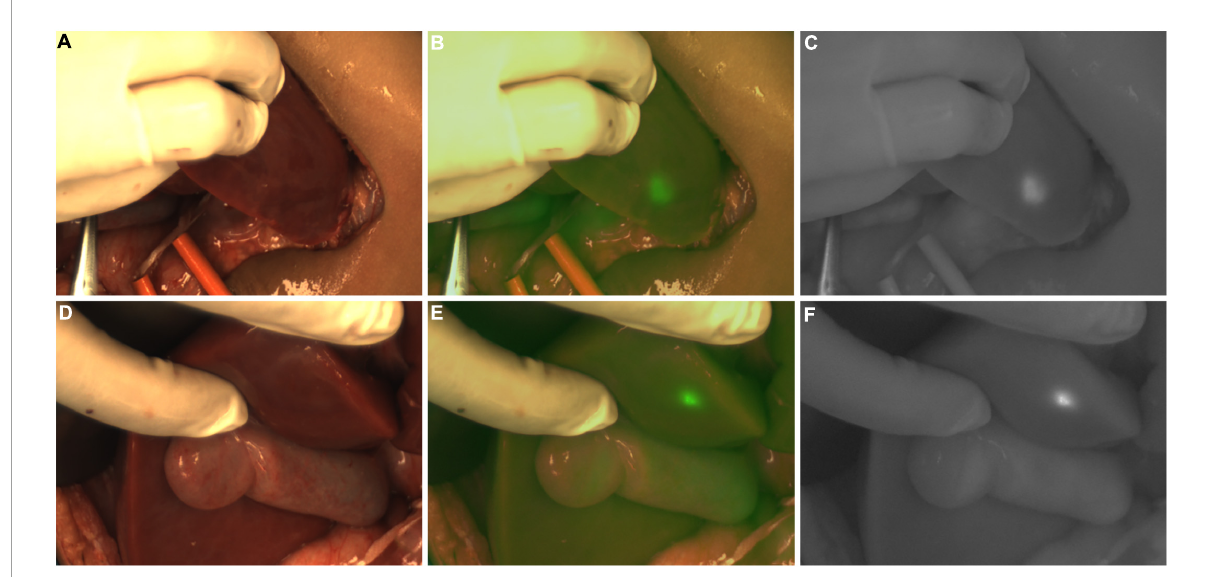
FIGURE8 Case 10. Intraoperative near-infrared photography of ICG (+) lesions in the left lobe (A–C) and caudate lobe (D–F) of the liver. The white-light image, fusion image and fluorescence image are shown in turn from left to